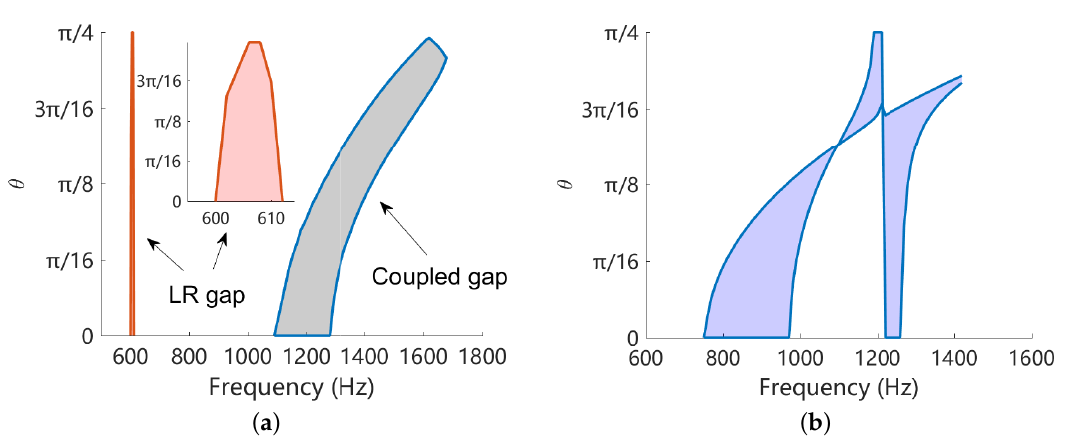
Figure 16. ( a ) Comparison of coupled band gaps created by L-network with L = 0.1 H and LR band gap created by L-shunt with L = 0.4 H. The overall inductance of of such two cases are the same; ( b ) Variation of the angular width of band gaps with respect to the frequency, for L-shunt with L = 0.05 H. In this case the LR band gap is merged with the Bragg band